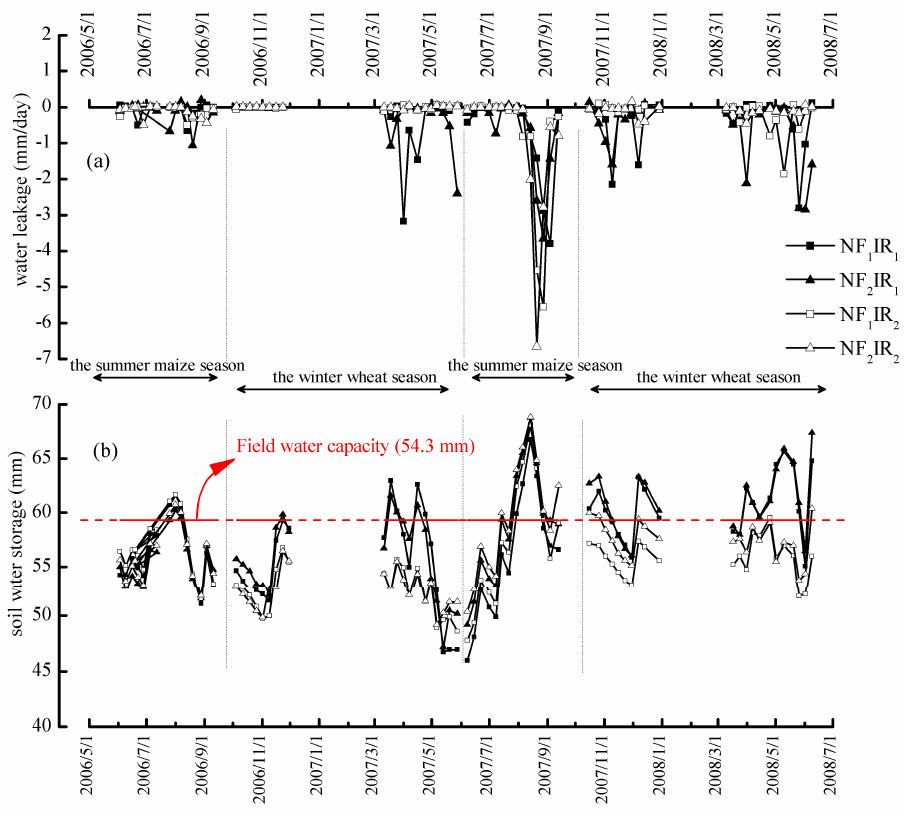
Figure 3. Water leakage and soil water storage ( a ) water leakage at a depth of 2.0 m under different fertilizer and irrigation management practices; ( b ) soil water storage in the 0–2.0 m soil profile.